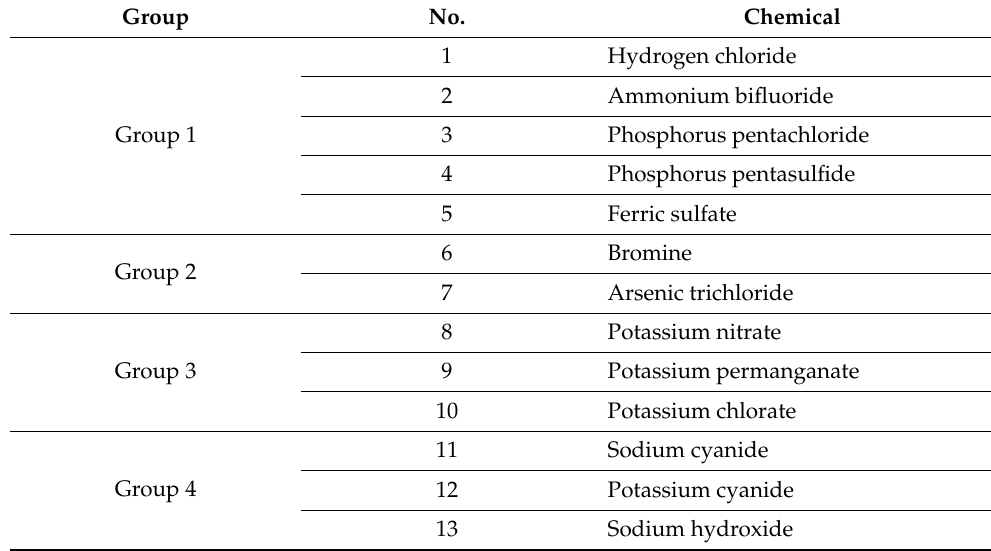
Table 3. Group classification of the 13 chemicals.